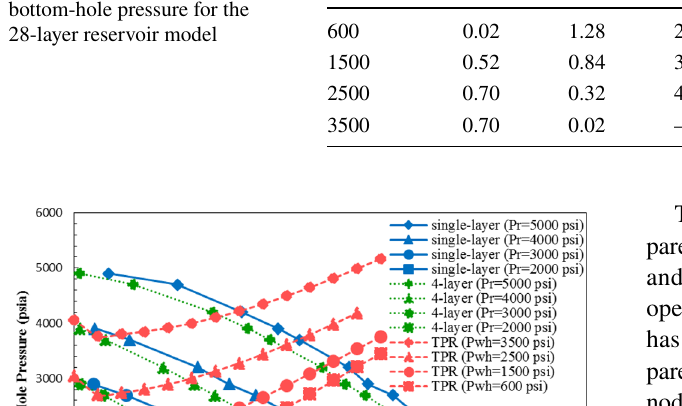
Table 12 Percentage of relative error of nodal analysis in predicting production rate and bottom-hole pressure for the 28-layer reservoir model